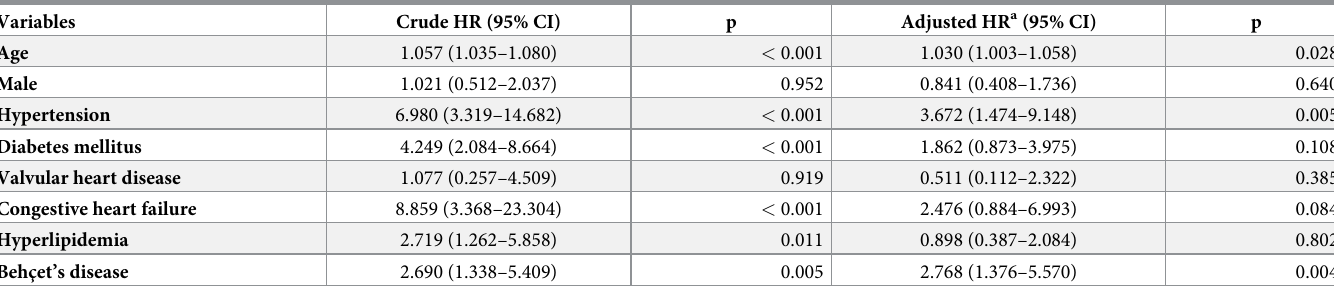
Table 2. Independent predictors of ischemic stroke in patients with